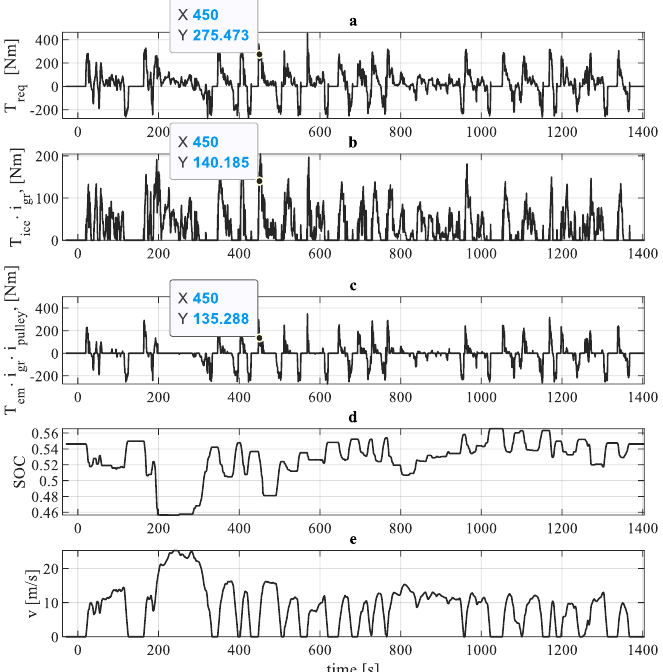
Figure 8. ( a ) Requested torque, ( b ) ICE torque, ( c ) EM torque at the gearbox output level, ( d ) SOC profile under ECMS controller with TCF, checking for demand fulfillment by the power sources